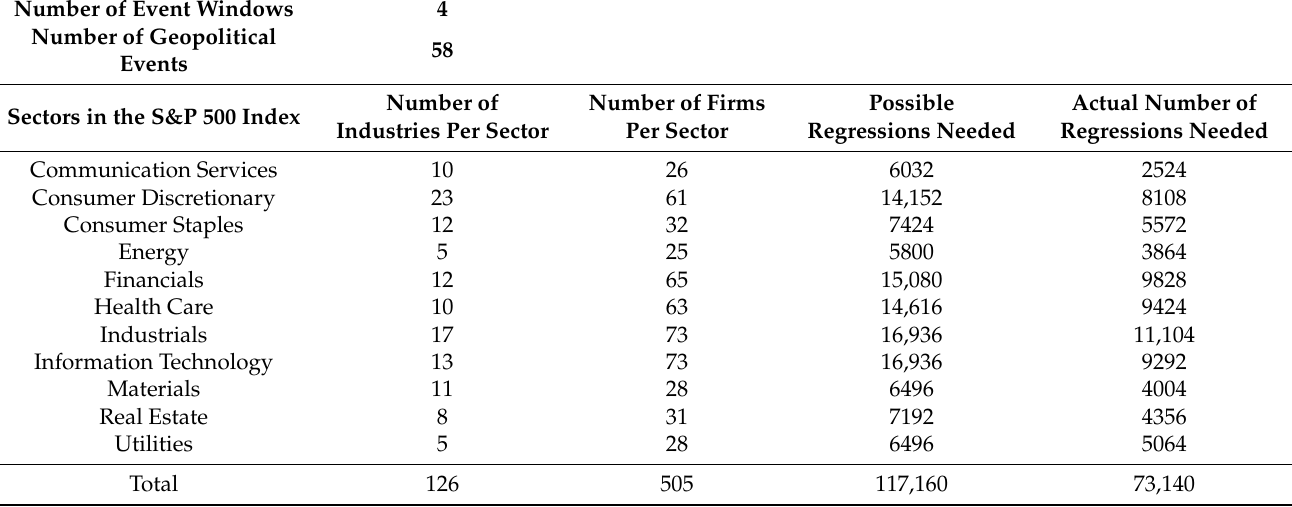
Table A5. Summary of event study regressions needed vs. possible regressions for the S&P 500